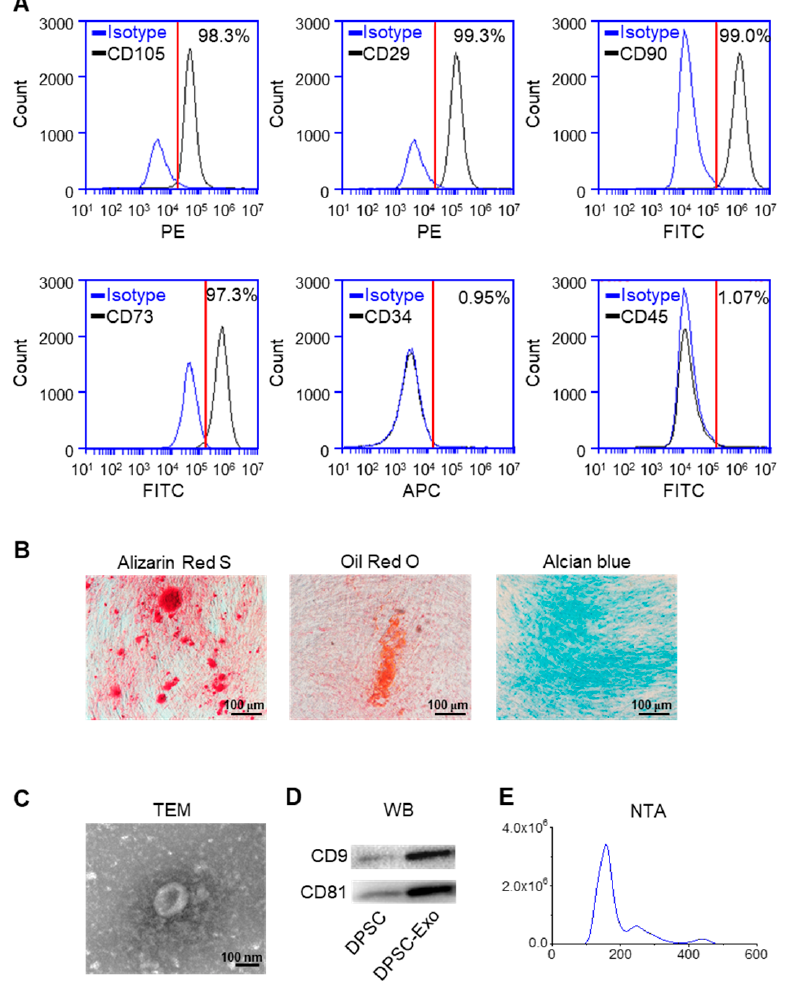
Figure 1. Identification of human DPSCs and exosomes. ( A ) The flow cytometry analysis showed that the DPSCs highly expressed CD105, CD29, CD90, and CD73, while CD34 and CD45 were almost not expressed in the DPSCs. Red line: the threshold of positive cells. ( B ) Alizarin Red S, Oil Red O, and Alcian Blue staining showed that the DPSCs had the capacity for multi -lineage differentiation after osteogenic, adipogenic, and chondrogenic induction, respectively. ( C ) Transmission electron microscope image of DPSC-Exos. ( D ) The Western blot results showed high expression of exosome-specific markers CD9 and CD81 in the DPSC-Exos compared with the DPSCs. ( E ) The particle size distribution of DPSC-Exos was analyzed by NanoSight.